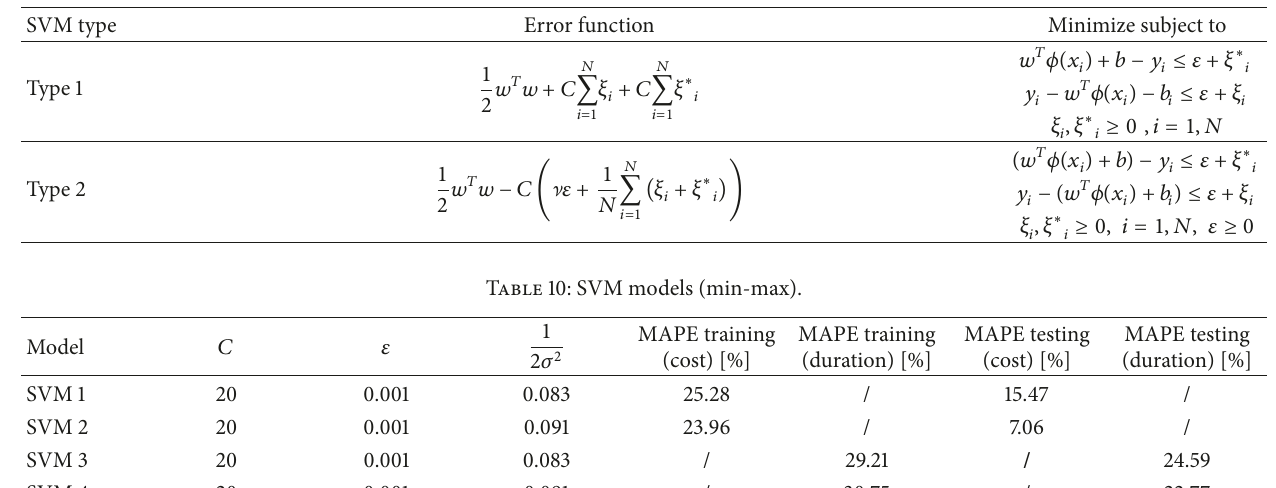
Table 9: Functions of error of SVM models.